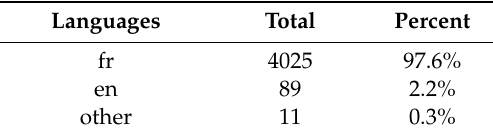
Table A19. Primary languages (fr).